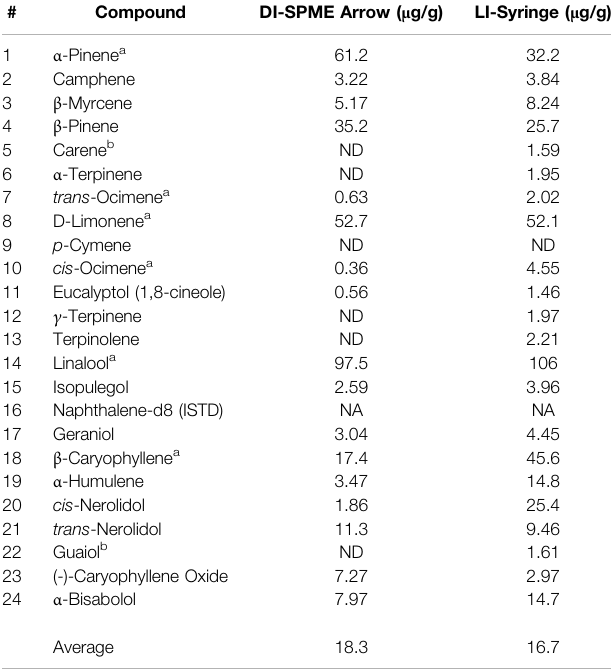
TABLE 7 | Mint Chocolate Chip terpene content determined by DI-SPME Arrow and LI-Syringe.